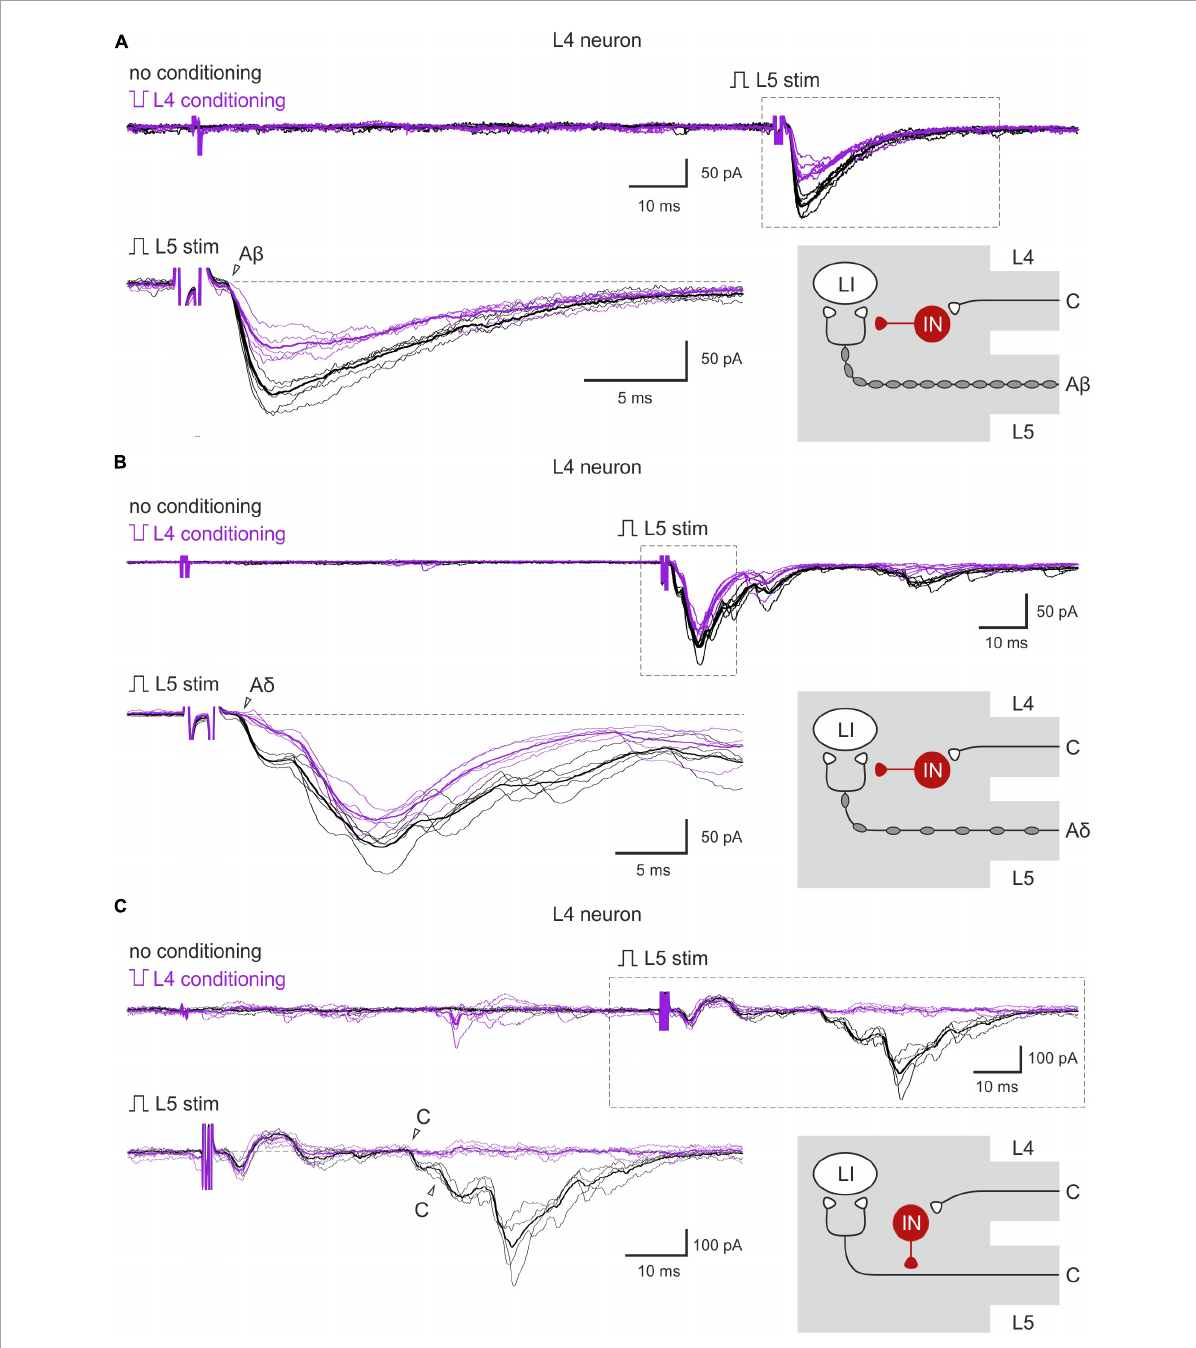
FIGURE4 Heterosegmental AD-PI: the L4 C-fibers control the L5 afferent input. (A–C) Excitatory postsynaptic currents (EPSCs) evoked by L5 root stimulation (normal pulse) in control (black) and after conditioning (inverted pulse) L4 root stimulation (purple). Individual and averaged (bold) EPSCs are shown. Decreased monosynaptic A β - (A) , A δ - (B) , and C-components (C) of the EPSCs are indicated by open arrowheads. Traces in the insets are shown below at higher magnification. Schematics showing PI induction are valid for both lamina I and X neurons. IN, inhibitory interneuron; LI, lamina I